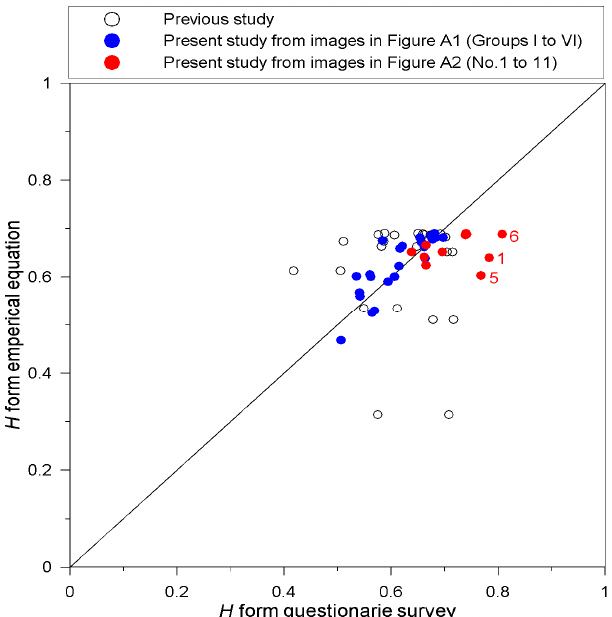
Figure 11. Relationship between the visual preference H from the empirical Equation (8) and H from the questionnaire survey. Data from the present study of a third-order urban stream and published results [29] for first- to second-order mountain streams. Images 5 and 6 have a high degree of artificial facilities ( I R + B R > 20%), while image 1 has less human intervention and is closer to its natural state.